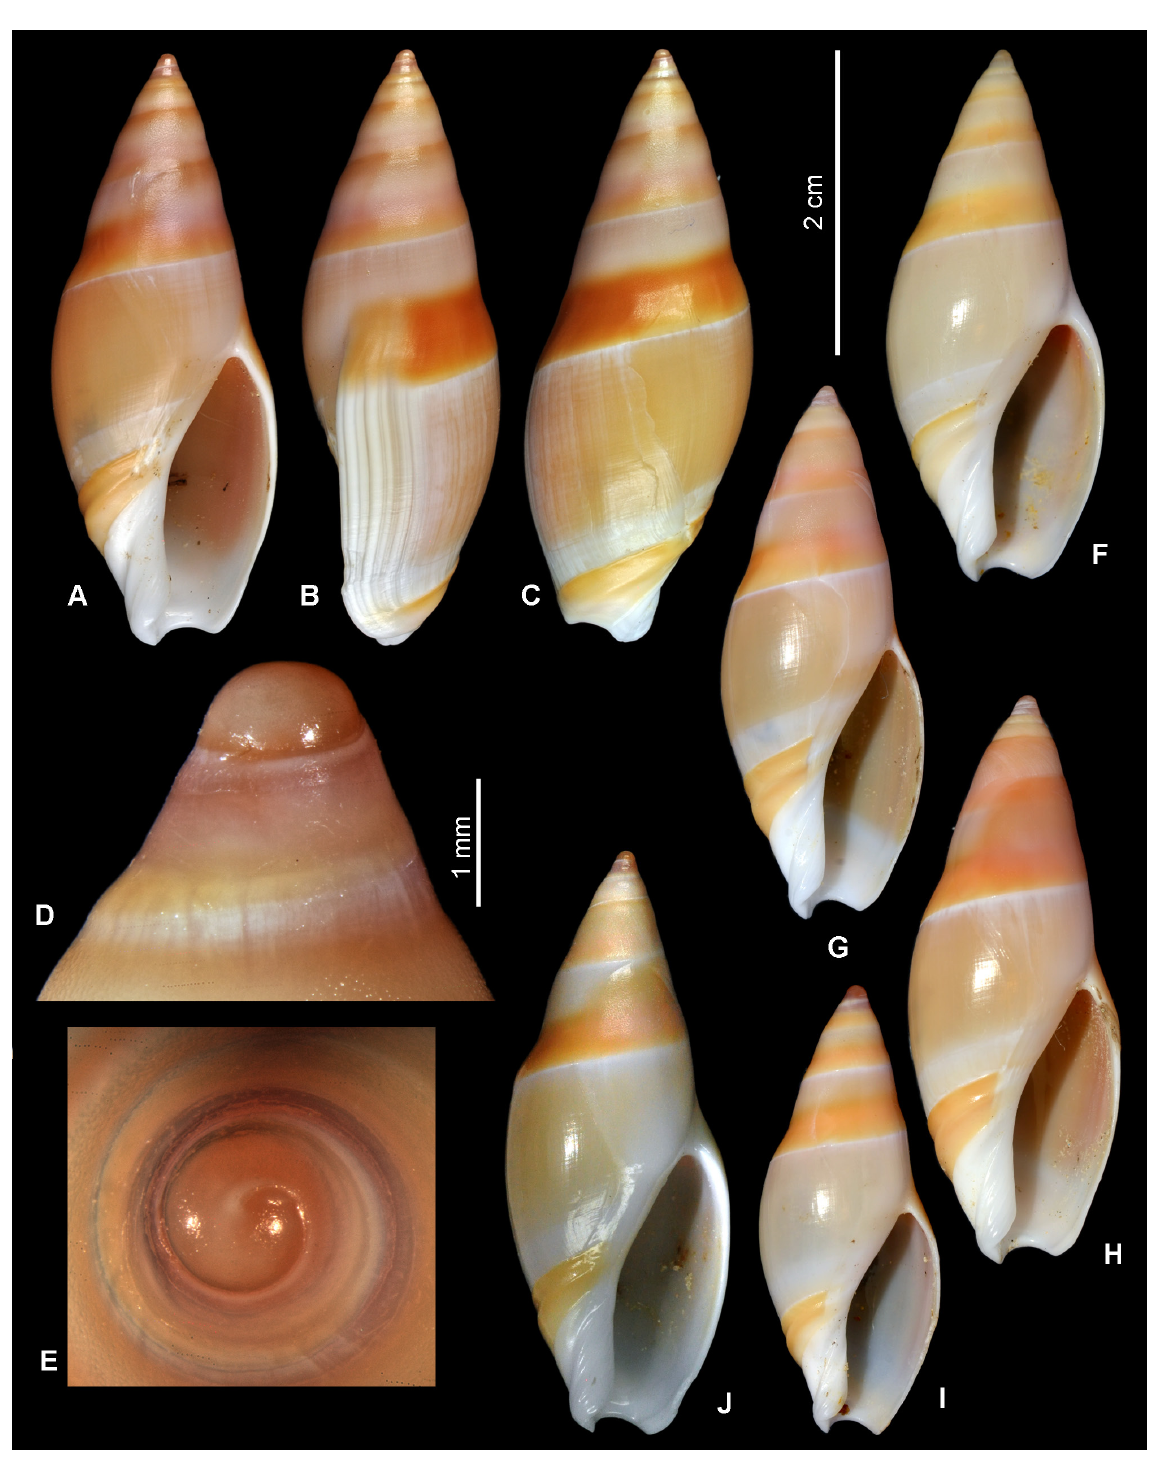
Fig. 10. Amalda miriky sp. nov., Madagascar. A–E . Holotype, MNHN IM-2007-36868, SL 39.6 mm (D–E = enlarged lateral and apical views of the protoconch). F . MNHN IM-2007-38073, SL 35.8 mm (specimen not sequenced). G . MNHN IM-2007-36842, SL 35.7 mm. H . MNHN IM-2007-36866, SL 37.9 mm. I . MNHN IM-2007-38064, SL 30 mm. J . Miriky, stn DW3215, between Nosy-Be and Banc du Leven, 12°32′ S, 47°54′ E, 316–433 m, SL 38.9 mm (specimen not sequenced, radula on Fig. 7J). Scale bars: A–C, F–J= 2 cm; D–E =